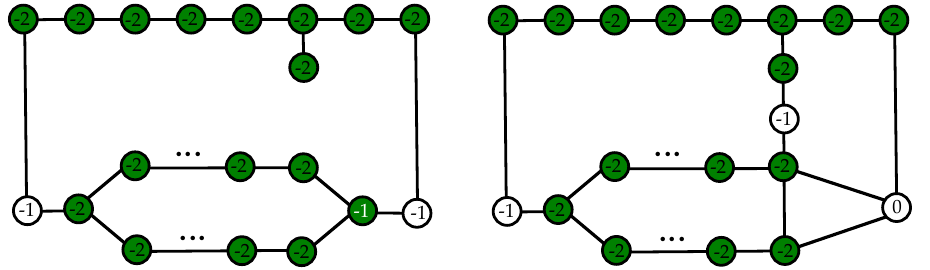
Figure 19 . The marginal CFDs for (E 8 ; SU(2 k )) and (E 8 ; SU(2 k + 1)) minimal conformal